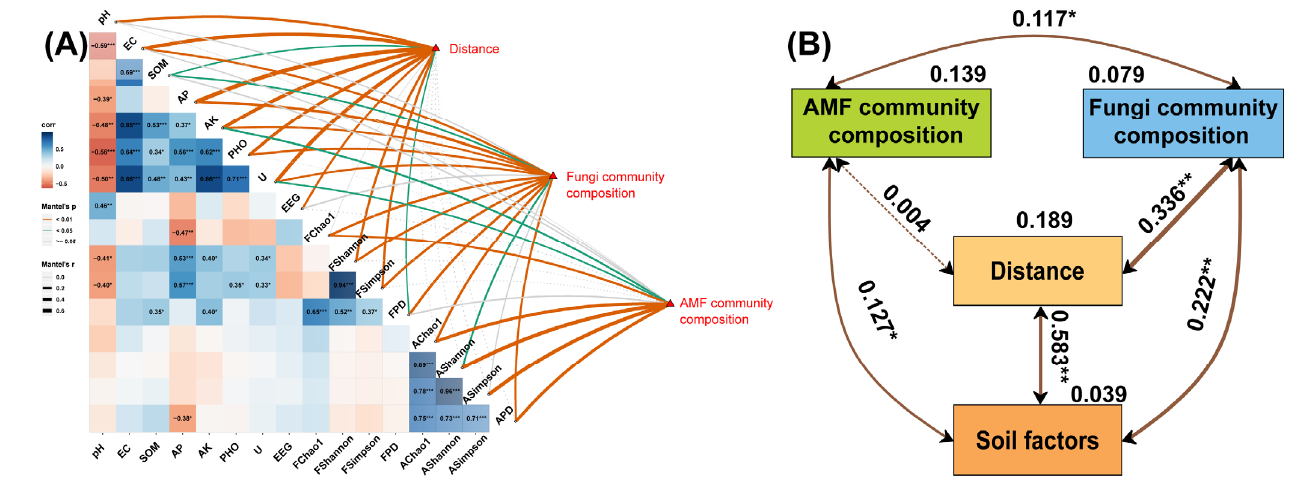
Figure 5. Relationships among distances, edaphic variables, AMF, soil fungal diversity indices, and composition of AMF and fungal community. Pairwise comparisons of edaphic variables and fungal indices with a color gradient denoting Pearson’s correlation coefficient in ( A ) (* p < 0.05, ** p < 0.01, *** p < 0.001). EC: electrical conductivity, SOM: soil organic matter, AP: available phosphorus, AK: available potassium, PHO: phosphatase, U: urease, EEG: easily extractable glomalin-related soil protein. FChao1: soil fungal Chao1, FShannon: soil fungal Shannon-wiener index, FSimpson: soil fungal Simpson index, FPD: soil fungal phylogenetic diversity, AChao1: soil fungal Chao1, AShannon: AMF Shannon-wiener index, ASimpson: AMF Simpson index, APD: AMF phylogenetic diversity. Solid lines and dashed lines indicate significant and non-significant pathways in ( B ), respectively. The width of the solid lines indicates the strength of the causal effect, and the numbers near the arrows indicate the value of R (* p < 0.05, ** p <